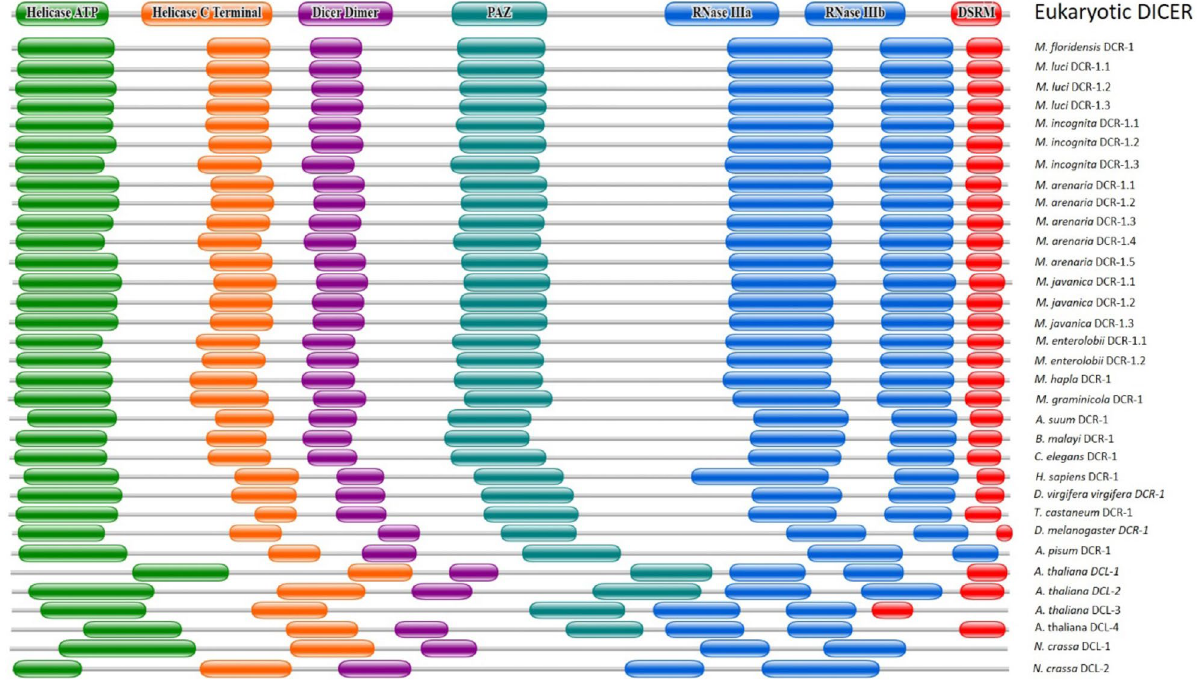
Figure 2. Predicted structures and arrangement of six major domains and a motif of DCRs putatively encoded by genomic contigs of eight Meloidogyne species compared to those characterised for a typical eukaryote and other nematodes, insects, plants and